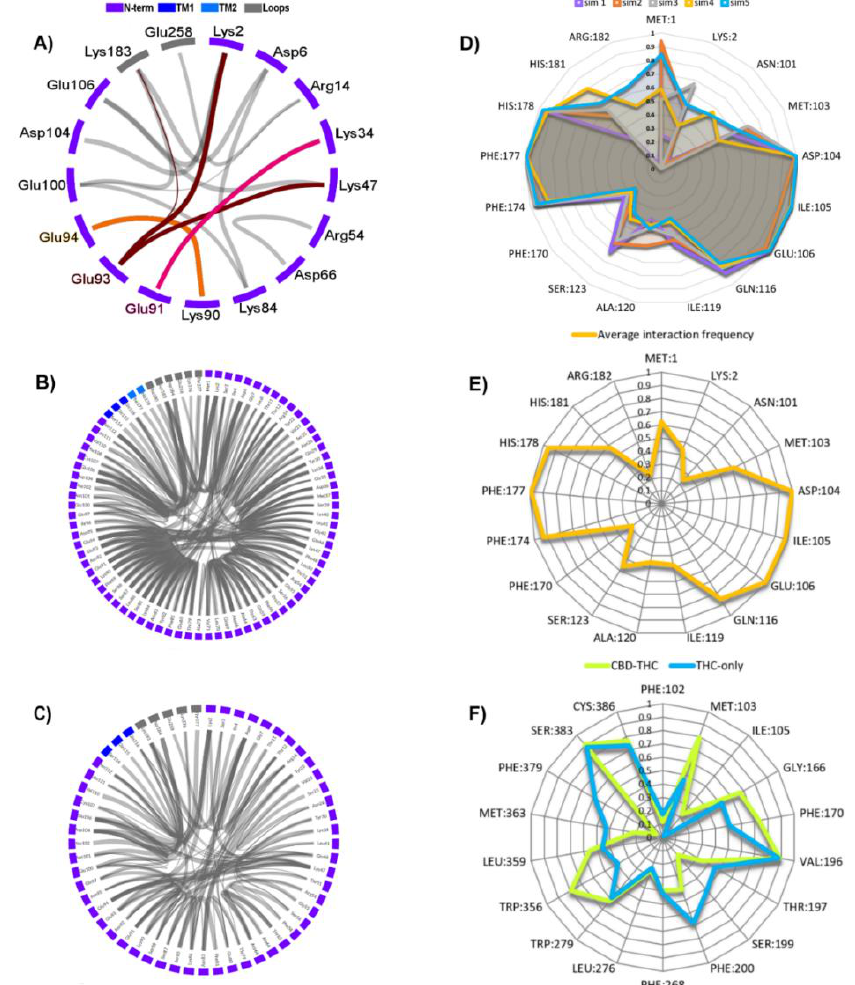
Figure 8. ( A – C ) Flare plots of crucial interactions responsible for stabilizing the N-terminal domain in THC-only complex). Line thickness is proportional to the frequency of the interaction; ( A ) Ionic interactions; highlighted are the interactions of E91 (pink), E93 (dark red) and E94 (orange), ( B ) Total hydrogen bonds of N-terminus; ( C ) The hydrogen bonds of N-terminus excluding backbone-backbone H-bonds; ( D , E ) Ligand-receptor dynamic interaction fingerprints in THC-CBD complex; ( D ) frequency fingerprints of interactions of residues with CBD for each simulation separately; ( E ) the average interaction frequencies of fingerprints from panel D; ( F ) the average frequency fingerprints of interactions of residues with THC for simulations with THC-CBD (green) and with THC-only (blue) bound to the CB 1 R.